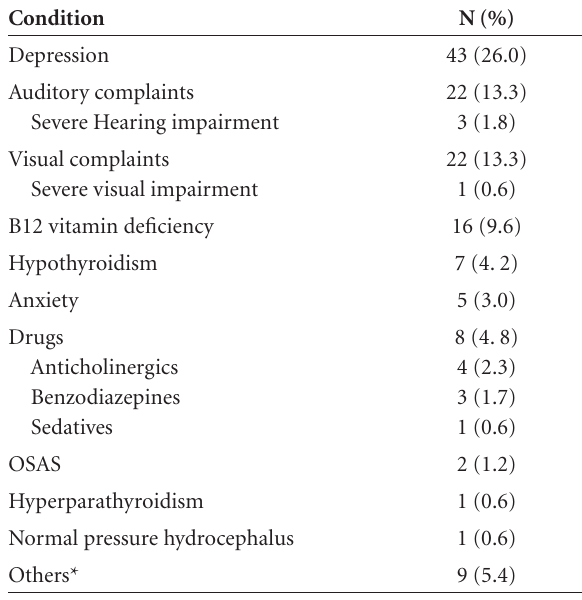
Table 1. Clinical conditions associated to memory complaints in elderly